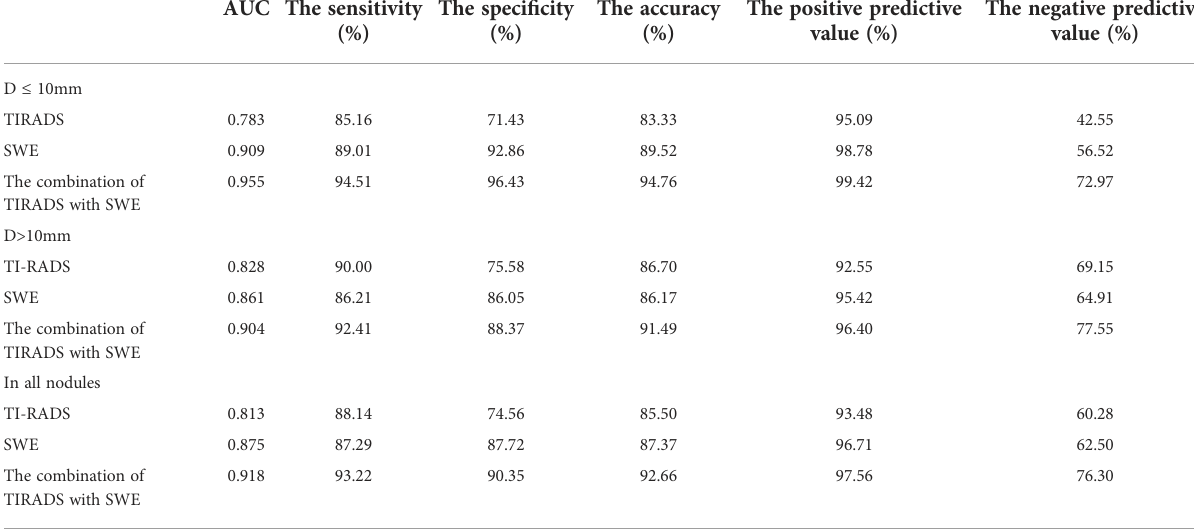
TABLE 5 Analysis of the diagnostic value of TIRADS, SWE and their combination in thyroid nodules. AUC The sensitivity